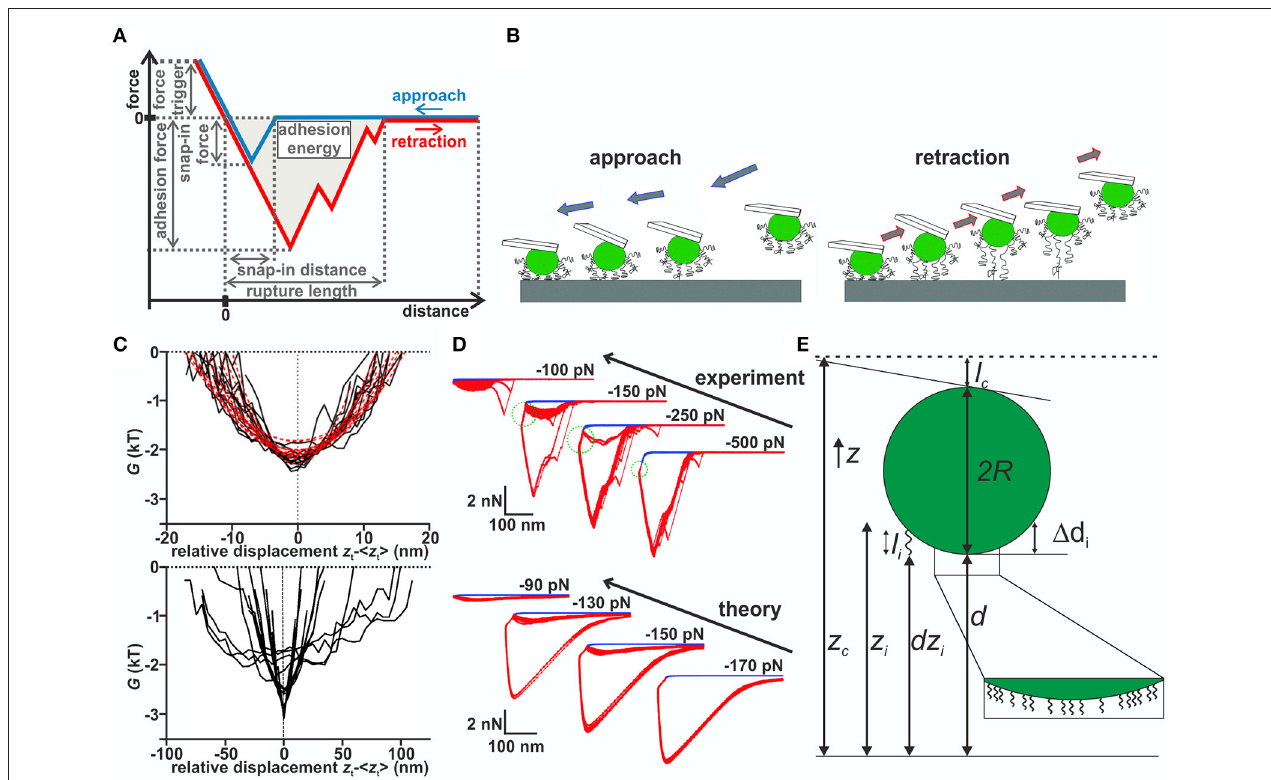
FIGURE 1 | (A) Schematic force–distance curve. (B) Sketch of the model: During approach (upper row), the most extend macromolecules start interacting with the surface and pull the bacterium closer to it, which allows more and more molecules to bind. Upon further approach, some molecules may be compressed. During retraction (lower row), the molecules are decompressed and then stretched before the detaching individually. (C) Gibb’s free energy in dependence of the relative displacement of Streptococcus salivarius cells with (top) and without (bottom) fibrillar surface tethers (van der Westen et al., 2018). Image taken from https://pubs.acs. org/doi/10.1021/acs.langmuir.7b04331. For futher information and permissions refer to ACS. (D) Partitioned force–distance curves (from experiment and simulations) with varying force trigger. A smaller negative (larger absolute value) force trigger means that the retraction starts later ( Thewes et al., 2015b). Blue curves are individual approach curves, while red curves are individual retraction curves with the same cell. Note the bistable behavior of the retraction curves for intermediate force triggers, where either one or the other type of curve is observed for the same cell. The pulling regime is indicated by the green dotted circle. (E) Model details for Monte Carlo simulations by Thewes et al. (2015b): Sphere of radius R decorated with springs of length li connected at fixed height 1 d i from bottom of the sphere. The other end is dz i above the surface and interacts with the potential. In each step, the cantilever’s height z c is changed and a new equilibrium position d for the sphere